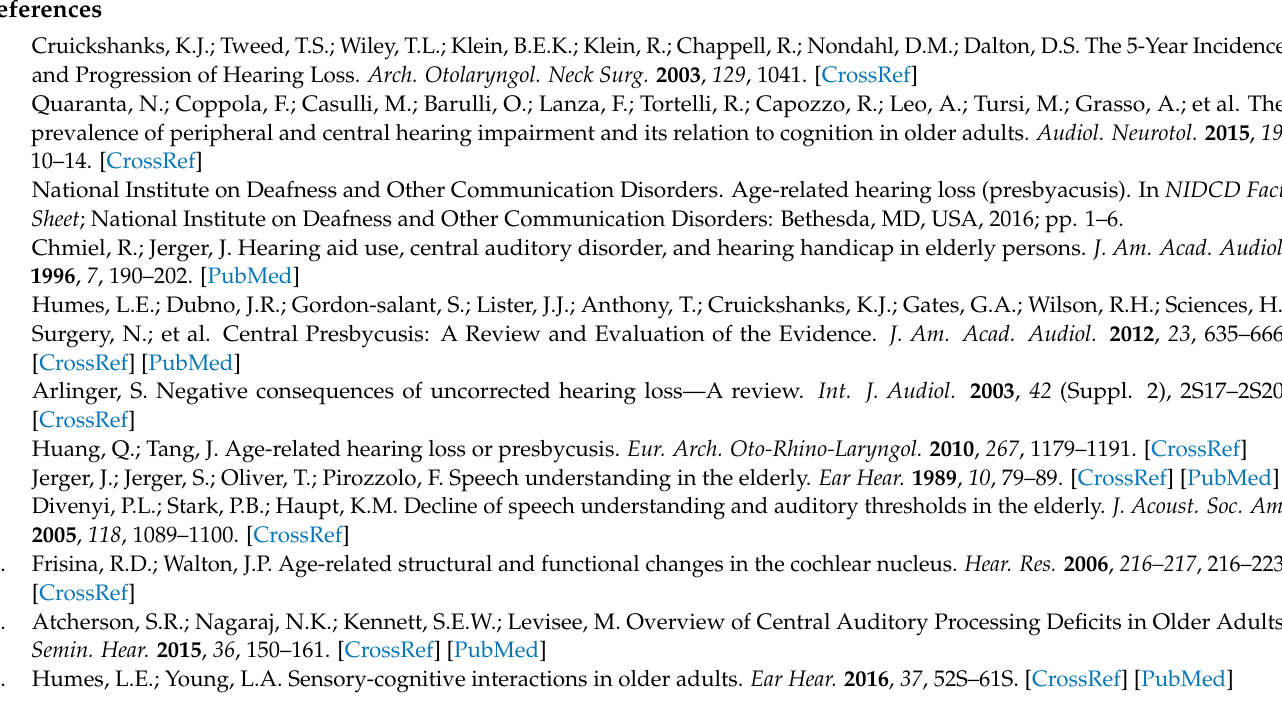
ables, Table S1: Values for Calculation of Low- and High-Frequency Measures, Table S2: Correlations between Low- and High-frequency Hearing Measure and Cognitive Control, Table S3: Correlation after Controlling for Trail Making